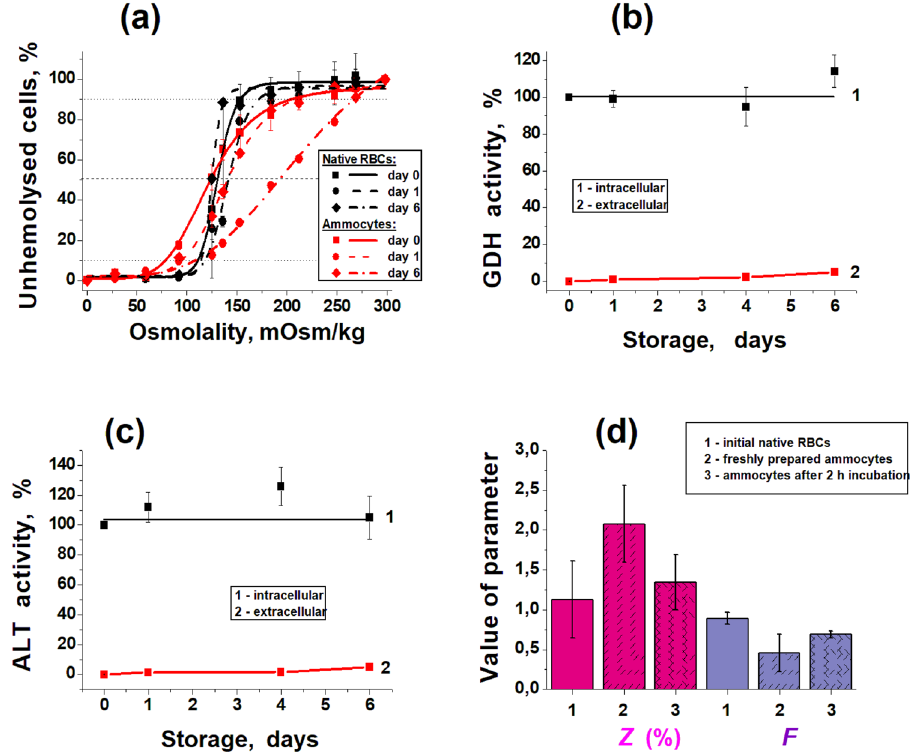
Figure 2. Properties of ammocytes and native RBCs. ( a ) The curves of osmotic fragility of ammocytes (red lines) and native RBCs (black lines) during storage at + 4 °C in 10% suspensions, expressed as the percentage of unhemolysed cells in dependence on solution osmolality. The measurements were carried out at day 0 (solid lines), day 1 (dash lines), and day 6 (dash-dot lines). Means ± SD are presented, n = 4. ( b , c ) GDH and ALT activities, respectively, inside the cells (1) and in the extracellular medium (2) as the percent of intracellular activity at day 0. Means ± SEM are presented, n = 8. ( d ) Filterability of native RBCs (1), freshly prepared ammocytes (2), and ammocytes, incubated for 2 h at room temperature (3), expressed as the fraction of cells unable to pass through the filter Z (%), or as index of filterability, F . Means ± SD are presented, n =